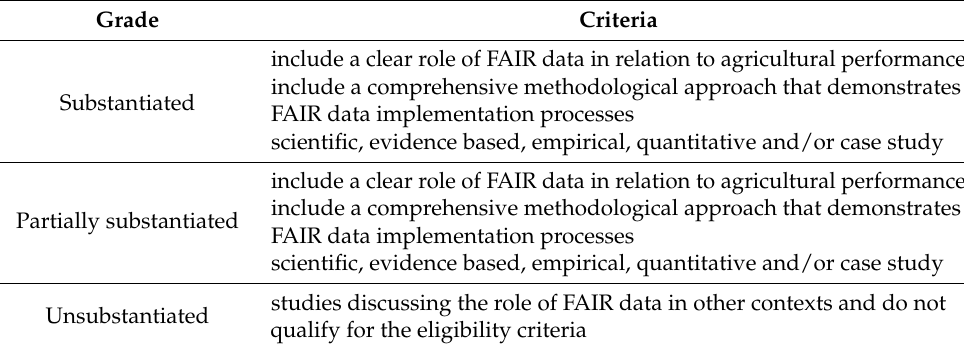
Table 1. Strength of evidence based on a grading